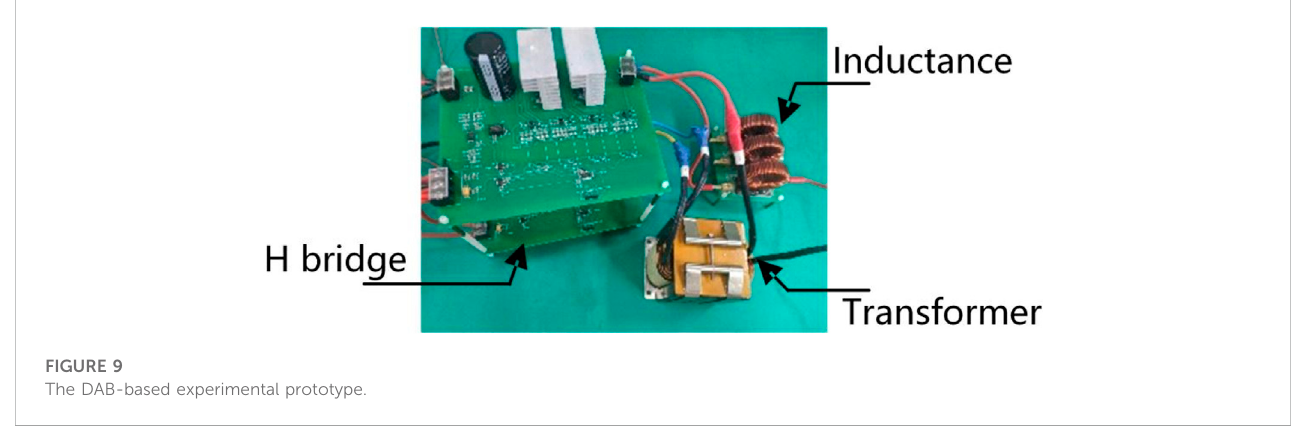
FIGURE 9 The DAB-based experimental prototype.